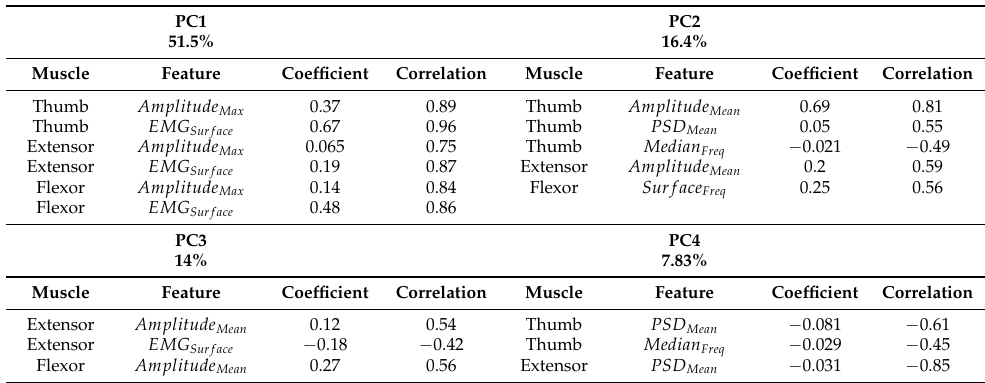
Table 4. PC coefficients and correlations between features and corresponding PC for the first scenario. Only | r | > 0.4 are shown.